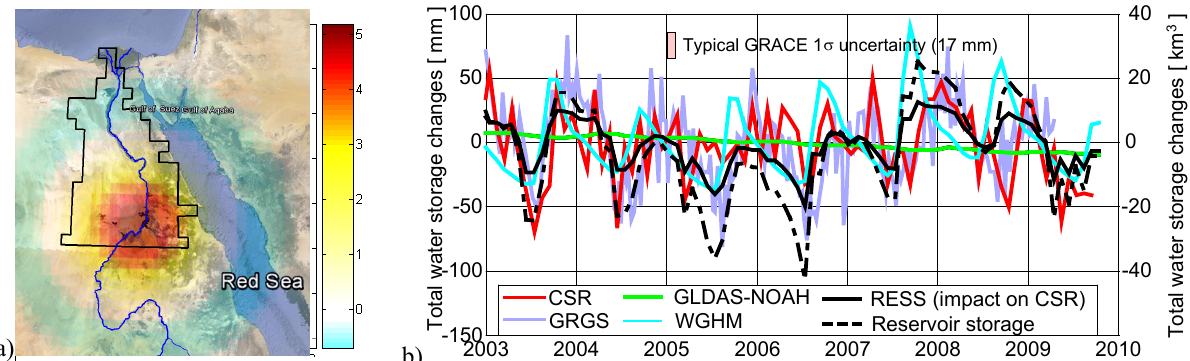
Fig. 3. (a) Google Earth map of the lower Nile basin (410000km 2 ); outlines are indicated in black. Superimposed is the apparent water storage change for a 1km 3 mass change (equivalent to a 160 mm lake level variation) distributed over Lake Nasser after hard SH truncation at degree 50 (similar to GRGS). Note the negative sidelobes associated with hard truncation. The outline of the area of interest is artificially set at the Egypt–Sudan border to focus on the very dry area and to compute the impact of a single point mass located at the border of the area of interest. (b) The colored lines show Nile basin total water storage (TWS) change anomalies from GRACE CSR and GRGS, GLDAS- SMS, WGHM (which includes Lake Nasser). Black lines show predicted impact of Lake Nasser on CSR ( 1 RESS – solid line, ABS) and the simple reservoir volume from altimetry uniformly distributed over the basin (dashed line, TBS). Lake Nasser accounts for 95% of the mass variability within the